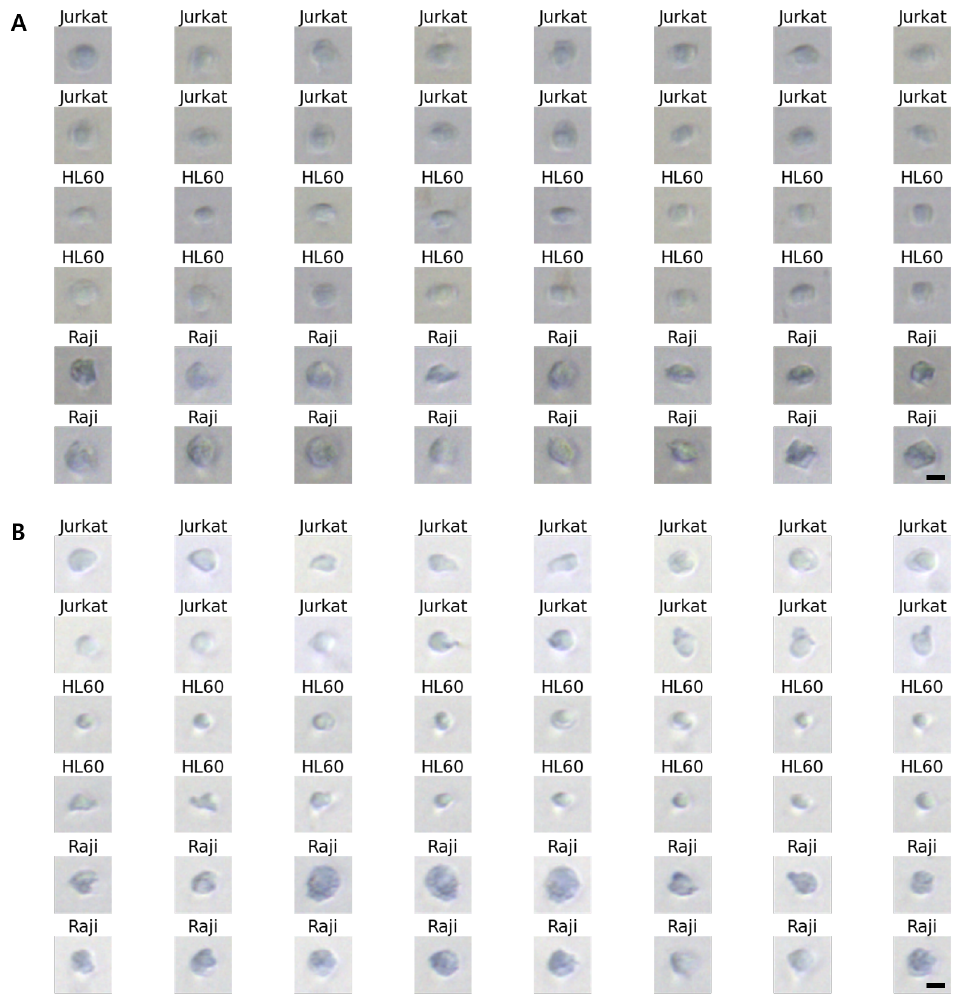
Figure 5. 10 × magnified Differential Interference Contrast (DIC) images of Jurkat, HL60, and Raji cells obtained using the upgraded system. ( A ) exposure time = 2 µ s, ( B ) exposure time = 4 µ s. Scale bars, 10 µ